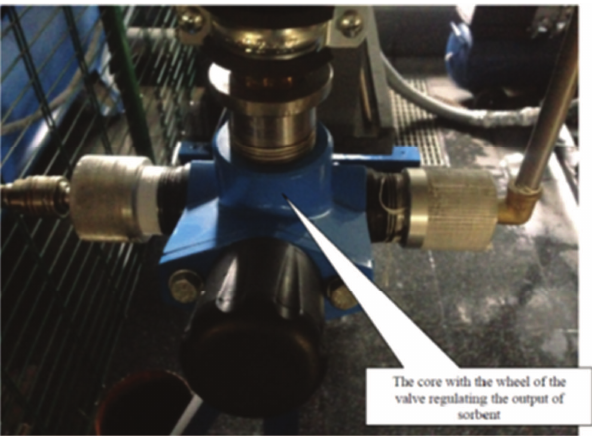
Fig. 5. View of the valve regulating the output of